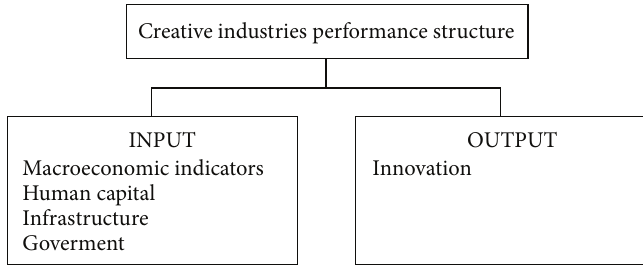
Figure 1. Creative industries performance structure (source: created by the authors)